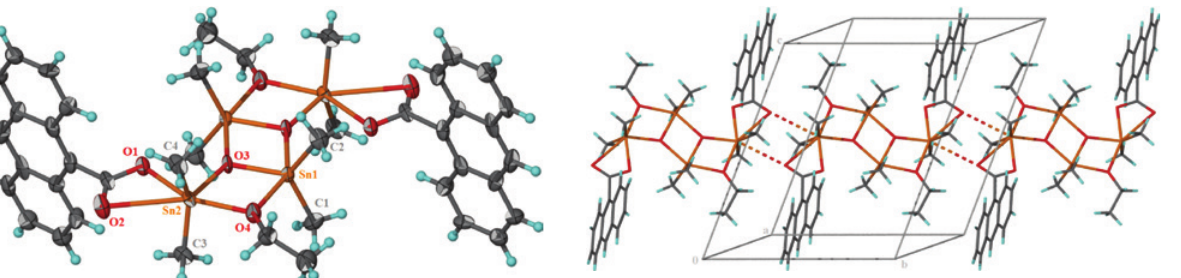
Figure 1: Molecular structure of complex 1 . Thermal ellipsoids scaled up to the 40% probability level.